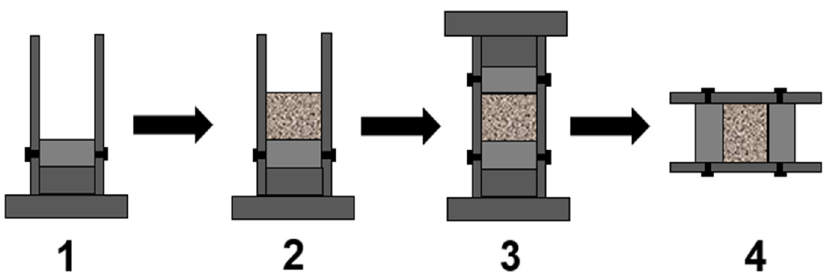
Figure 7. Steps of specimen fabrication. 1. Install the bottom base; 2. Install the sand; 3. Install the top base; 4. Placing horizontally.